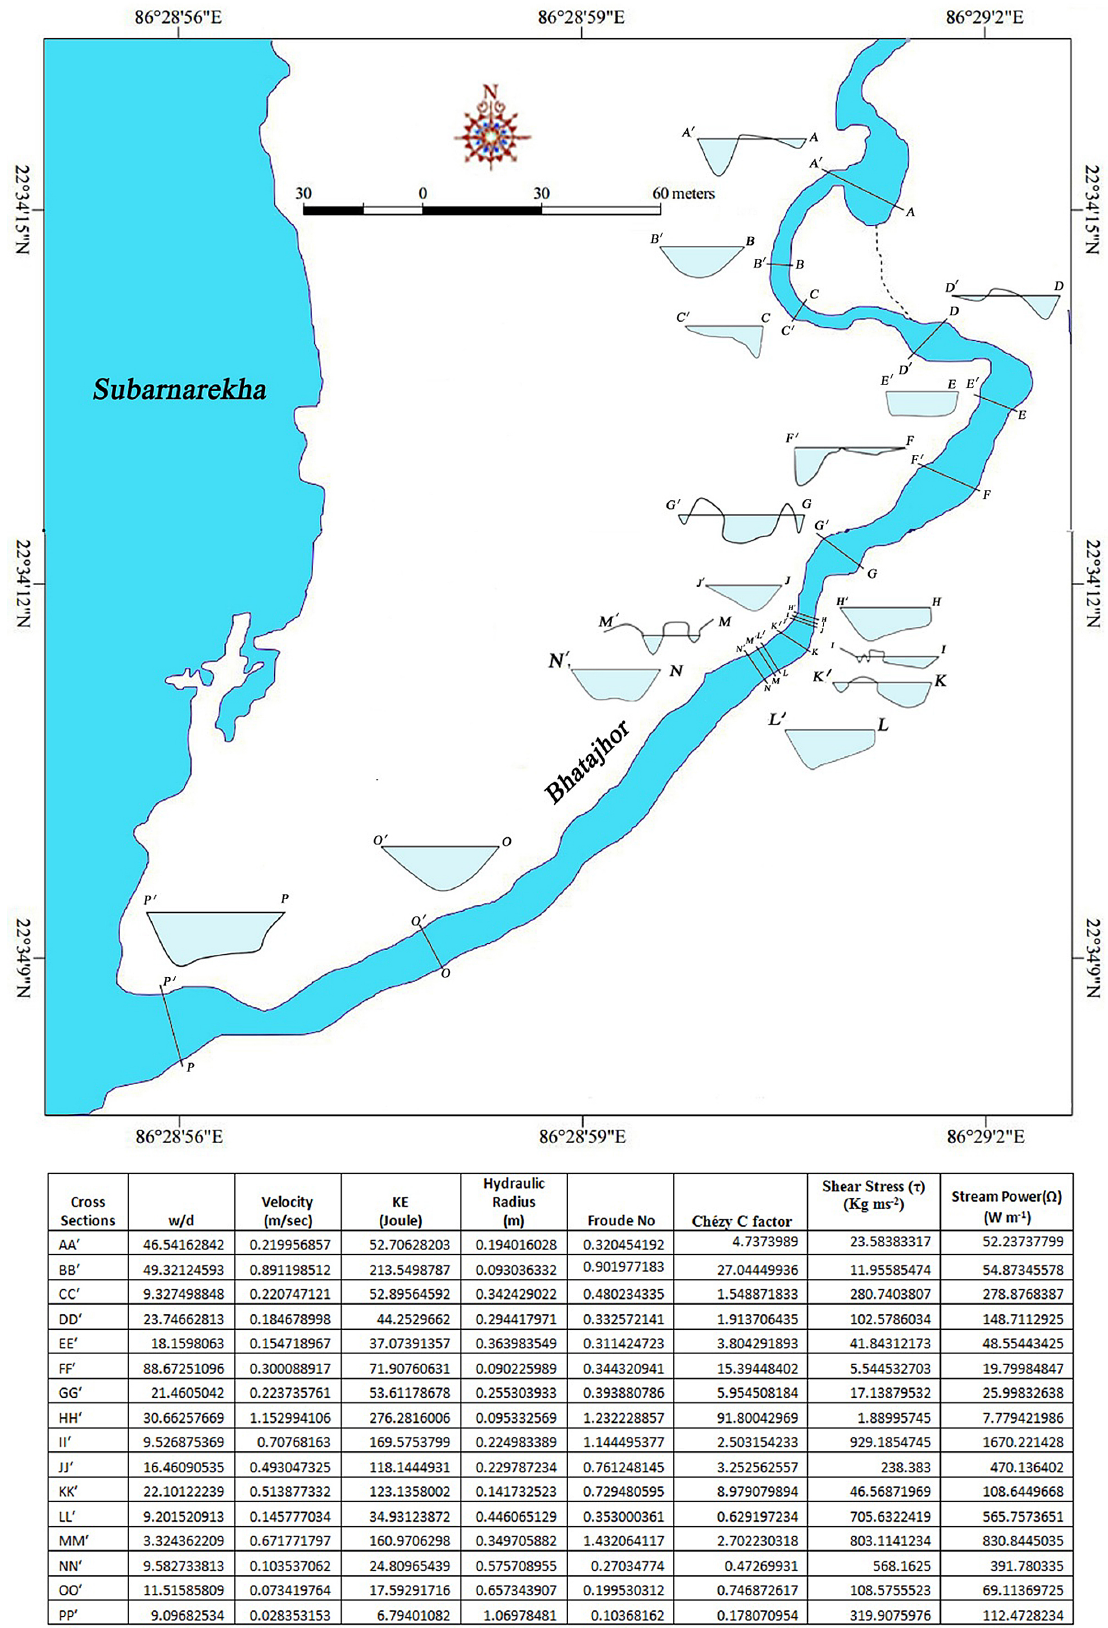
Fig. 3. Cross Sections of lower reach of Bhatajhor River (Cross sections are drawn on different